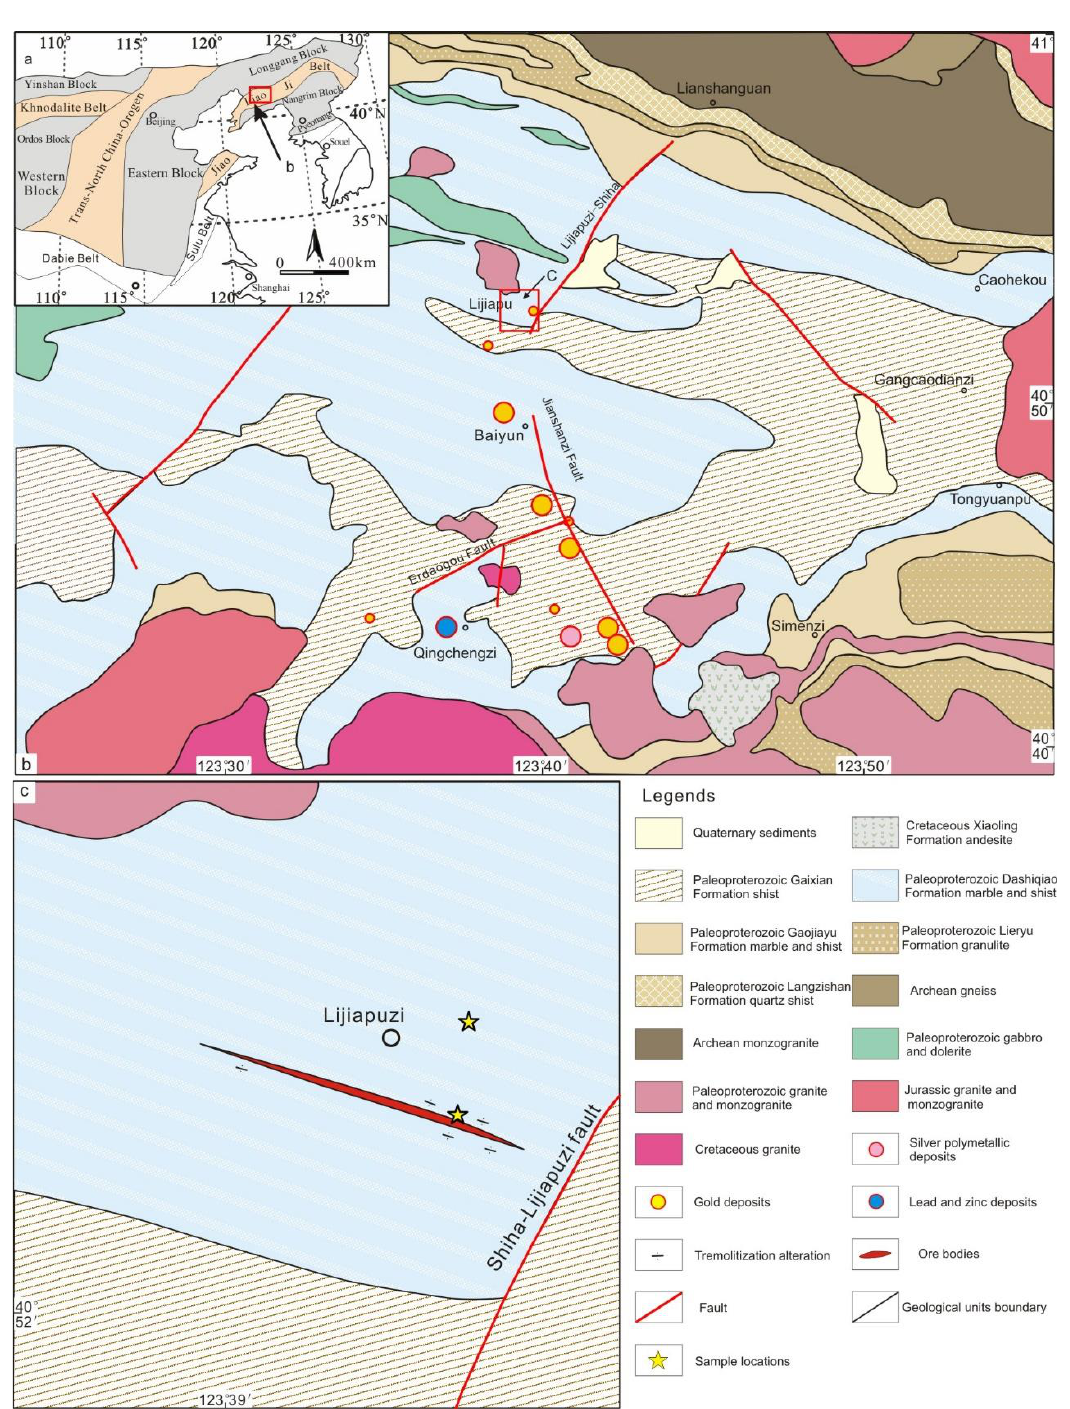
Figure 1. ( a ) Simplified tectonic map of partial North China Craton showing locations of the Liaodong Peninsula and the Jiao-Liao-Ji belt (modified after [2]). ( b ) Geological map of the Qingchengzi area showing major mineral deposits (modified after [13]). ( c ) Geological map of the Lijiapuzi gold deposit showing sample locations.